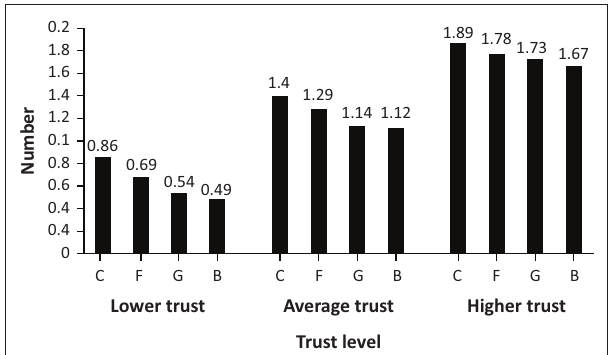
FIGURE 1: Compliance, fairness, good faith and benevolence at different trust